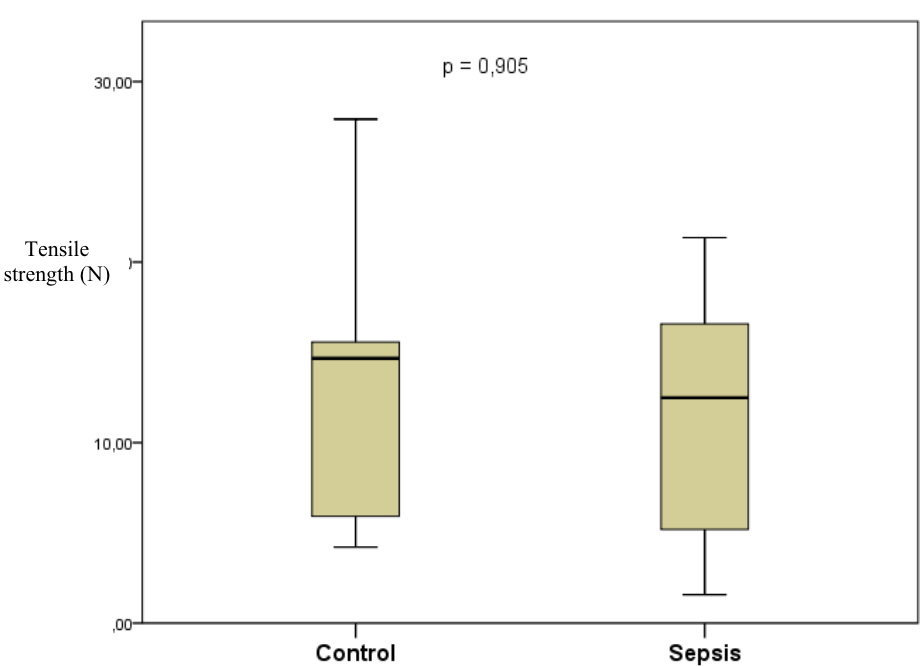
FIGURE 4 - Analysis of the breaking strength of animals euthanized on the 7 th postoperative day